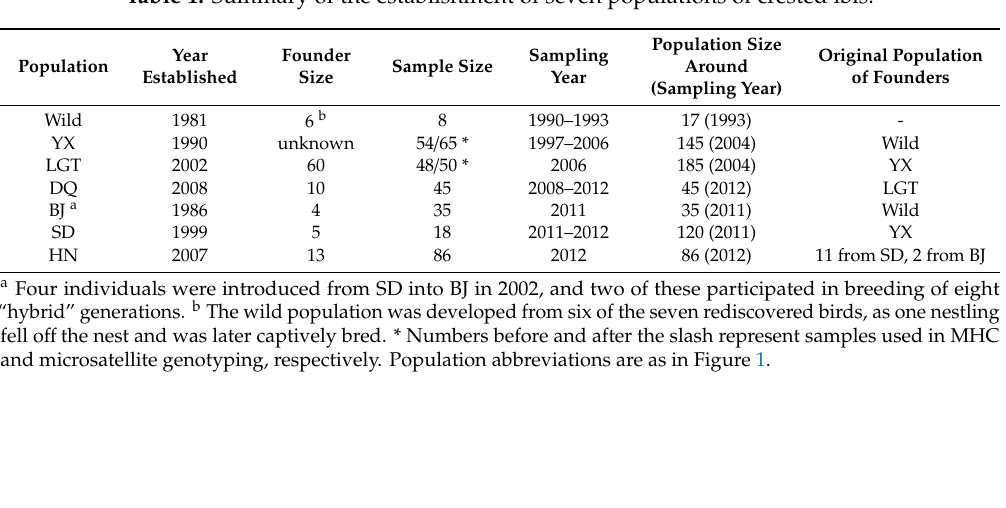
Figure 1. Map of the distribution and establishment of seven crested ibis populations (represented by red dots) in China (green lines) and Japan (blue lines). The SD population is from Sado Island, Japan, while the other populations are all from China. The year that each population was established is given beside the population name. Abbreviations for the six captive populations are: YX, Yangxian; LGT, Louguantai; DQ, Deqing; BJ, Beijing; SD, Sado; HN, Henan. The arrows represent the movement of founders with numbers indicated in the solid black circles. Table 1. Summary of the establishment of seven populations of crested